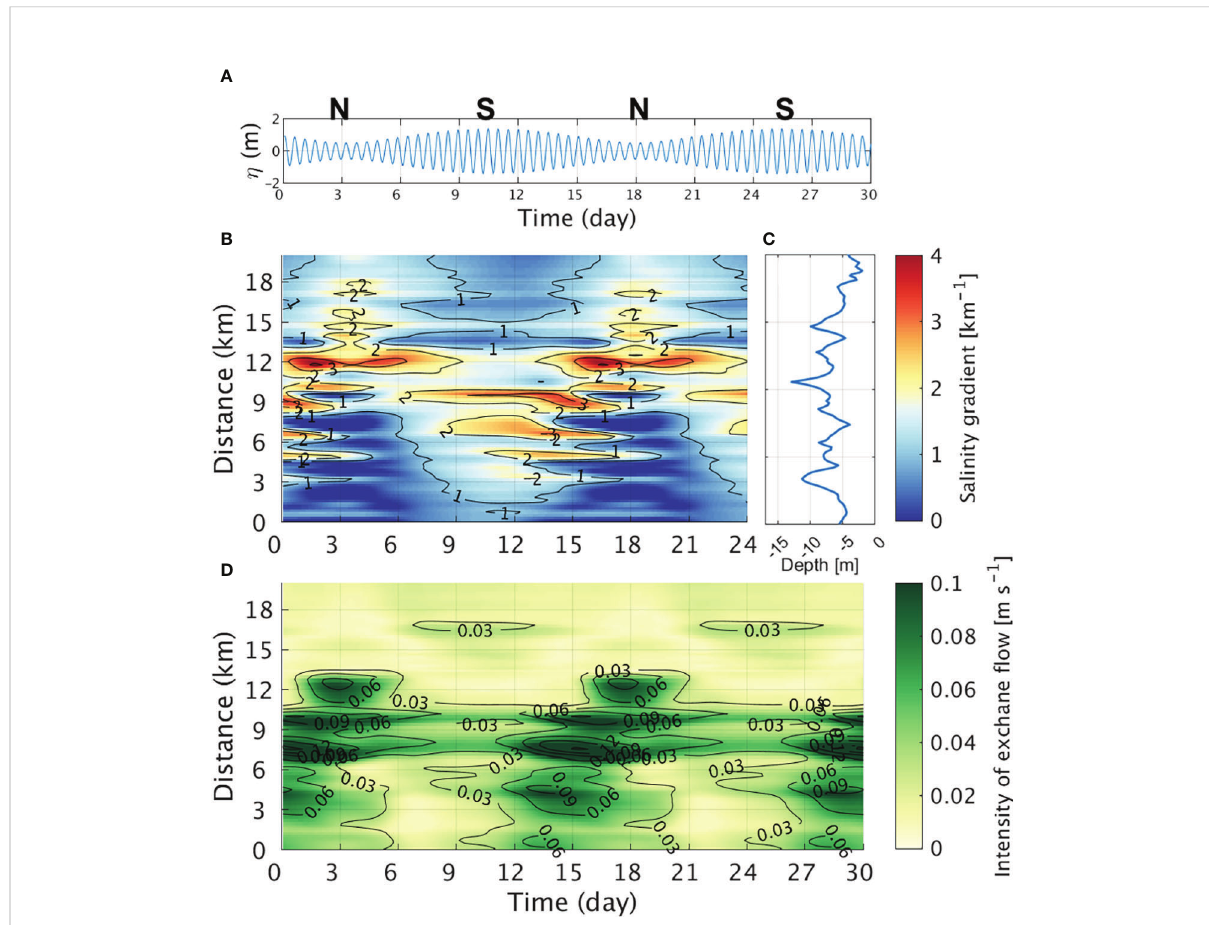
FIGURE 11 (A) Time series of sea-level height at the mouth of the real case and the N and S stand for neap tide and spring tide, respectively. Hovmöller diagram of (B) horizontal salinity gradient along the channel (unit: km -1 ). (C) Depth variation in the Sumjin River estuary toward upstream, which is averaged across the channel (unit: m). (D) Hovmöller diagram of the depth-averaged absolute value of the exchange fl ow (unit: ms -1